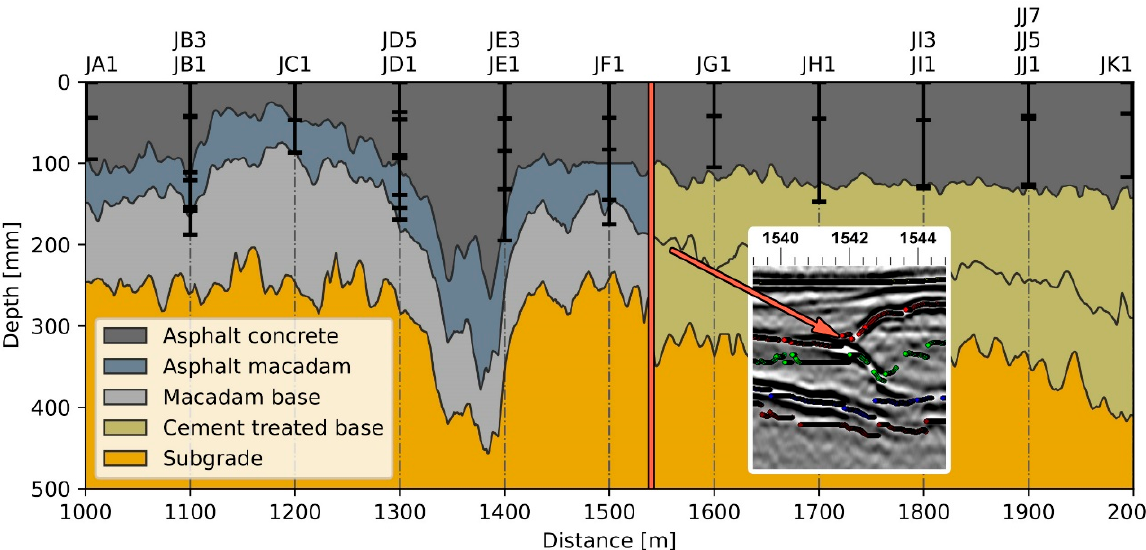
Figure 17. GPR thickness evaluation of asphalt and base layers, and the core sampling data points.